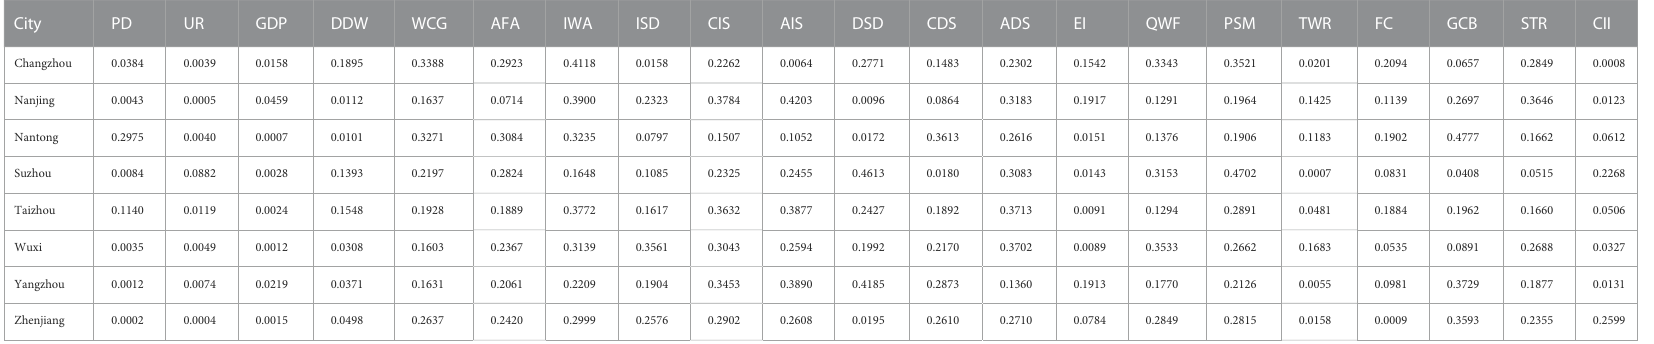
TABLE 6 Optimal projection direction in different cities.